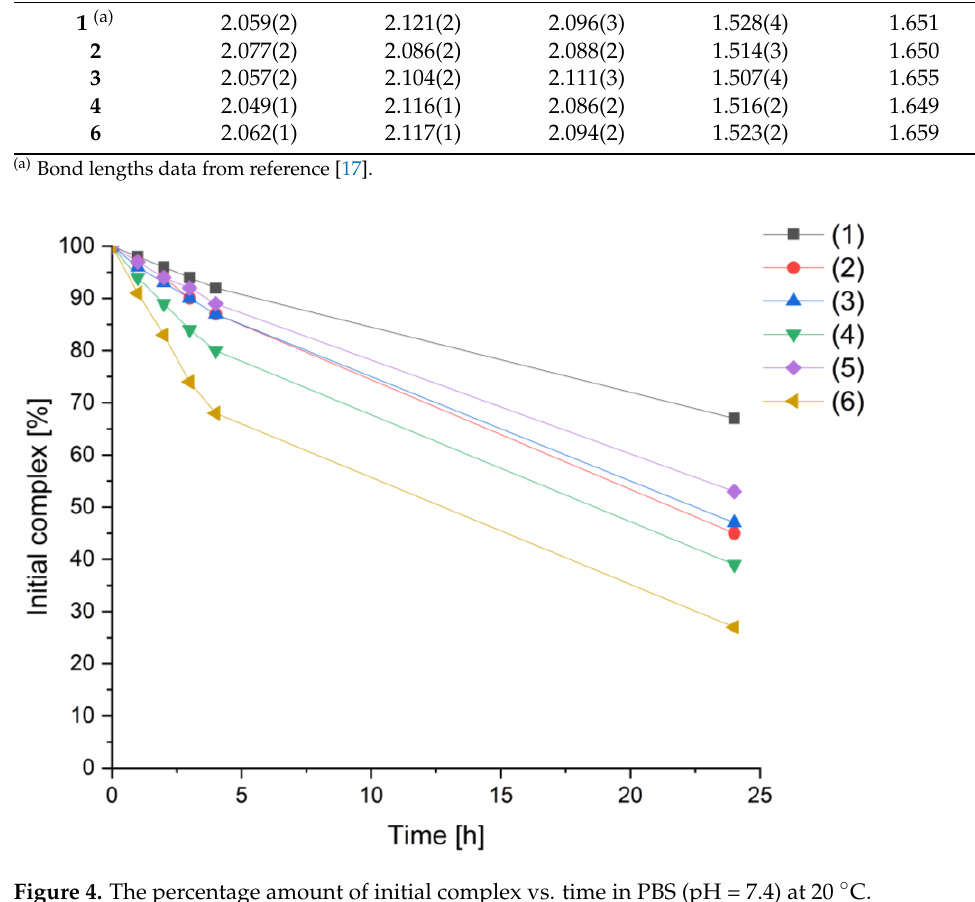
Table 1. Selected bond lengths of complexes 1 – 6 obtained X-ray single crystal diffraction [Å]. Ru- O 1